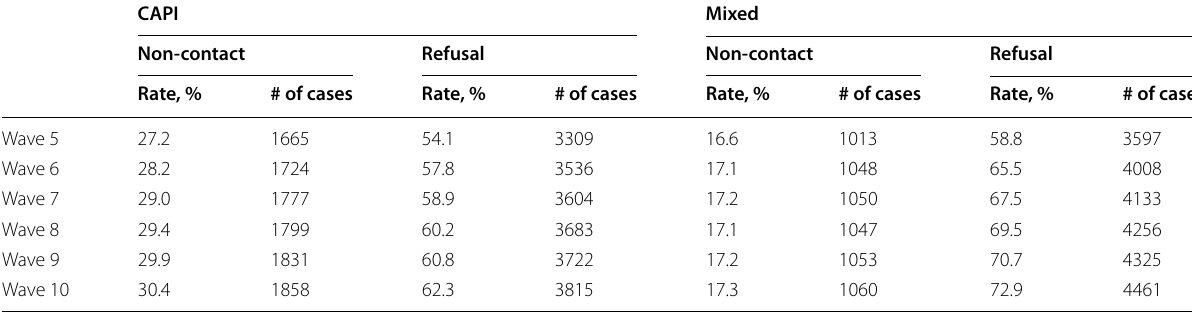
Table 4 Outcome rates and numbers of non-contacts and refusals, Wave 5–10